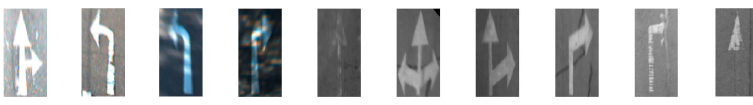
Figure 10. Examples of arrow markings after size normalization and bi-linear interpolation.